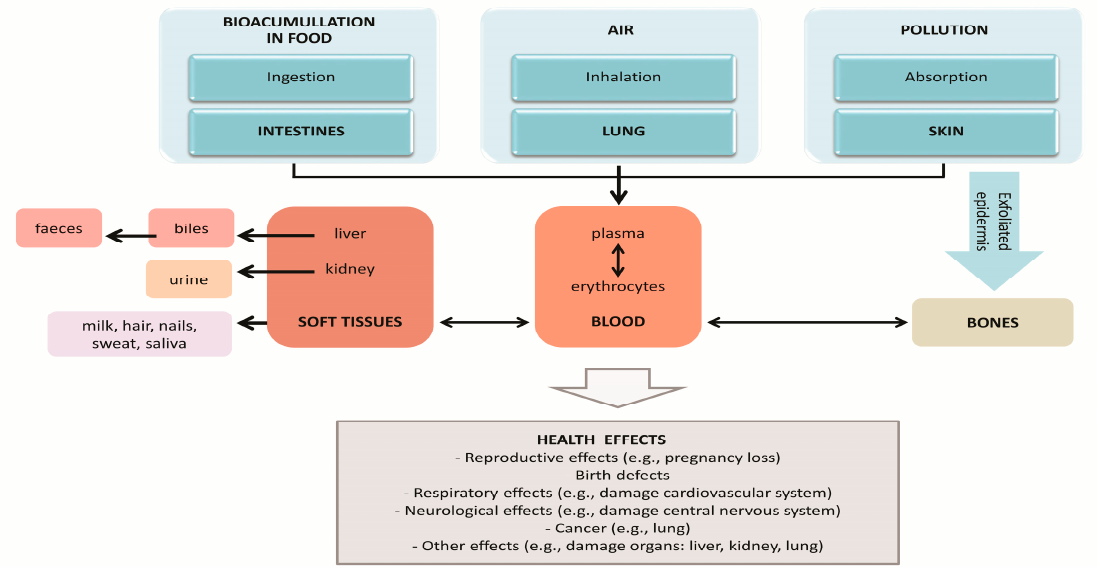
Figure 2. Absorption, distribution and excretion of Pb from the body (thin arrows—absorption paths; bold arrows—excreting pathways; dashed arrows—movement inside the body. The main locations of Pb in the body (blood, bones, soft tissues) [4,18,19].